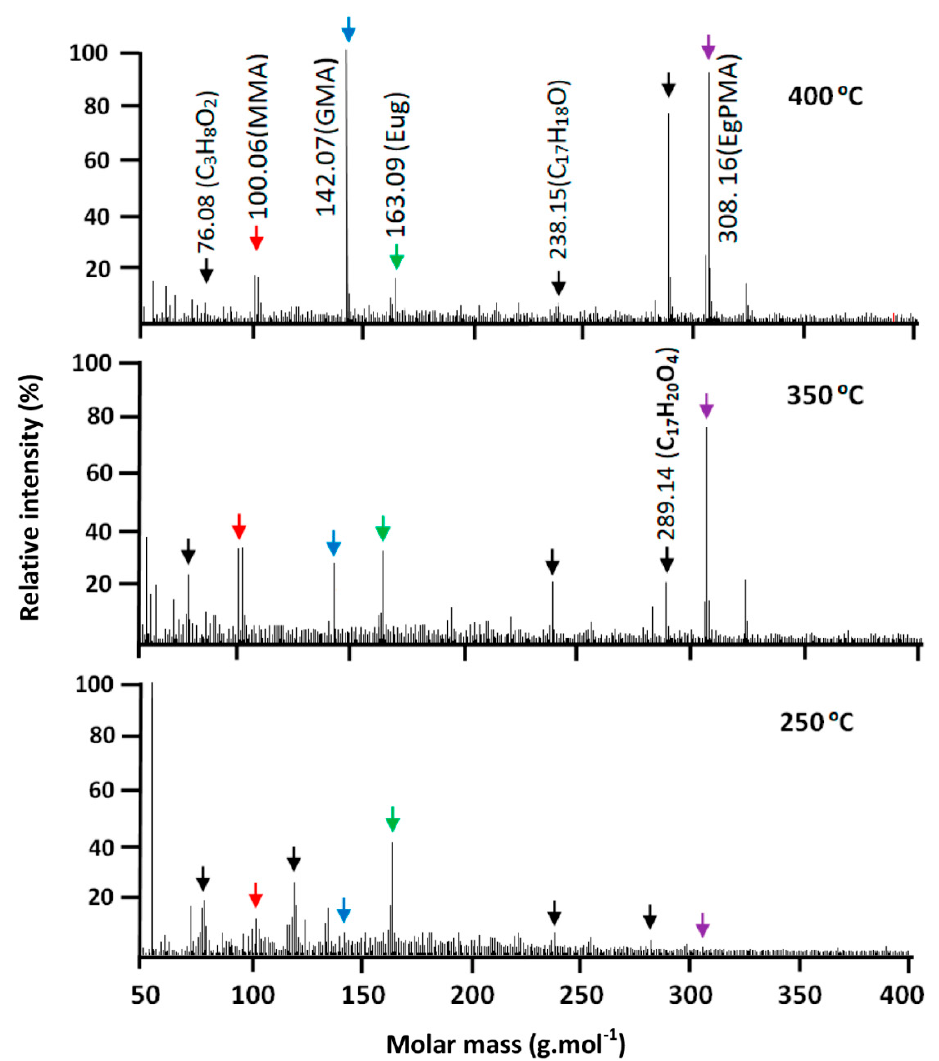
Figure 19. Thermograms of isothermal decomposition of PEUGMA-co-MMA indicating intensity of absorption signal attributed to resulting products vs. molecular weight.